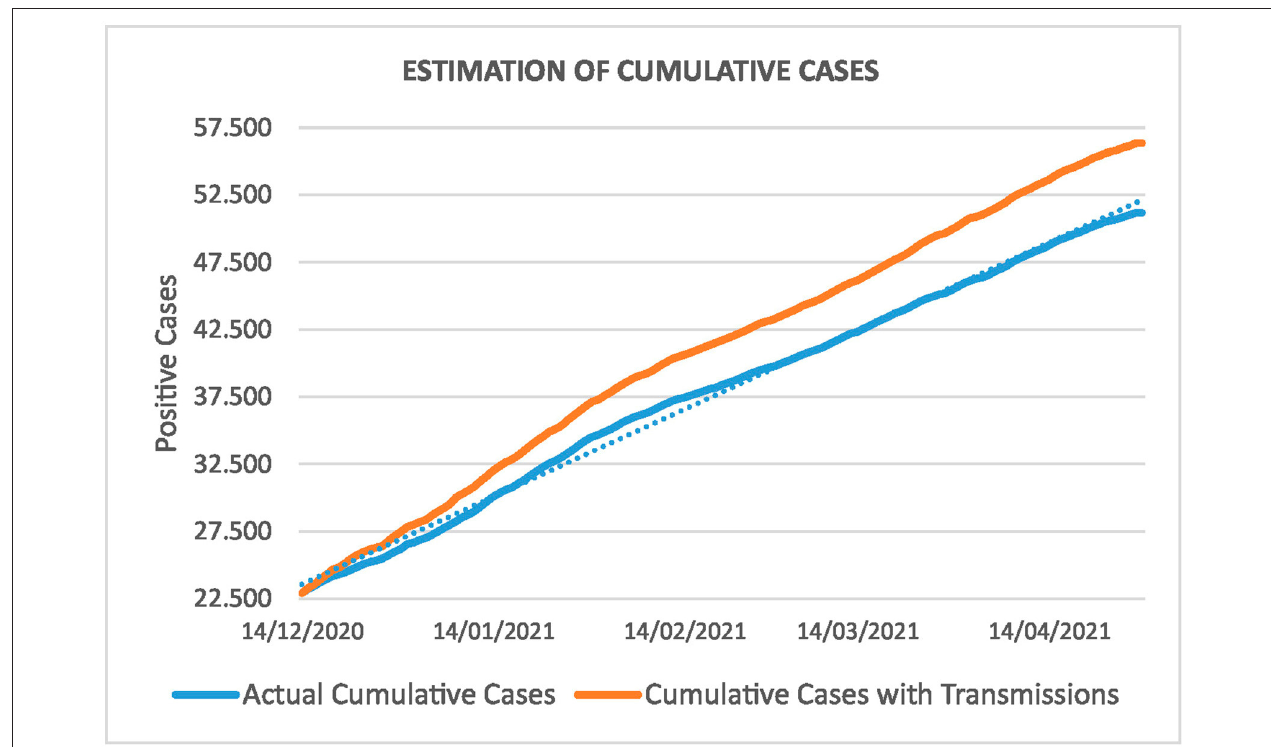
FIGURE 7 | Cumulative cases in the Canary Islands. The blue line represents the actual evolution of the pandemic and the orange one shows the forecasting if we consider transmissions from infected travelers.